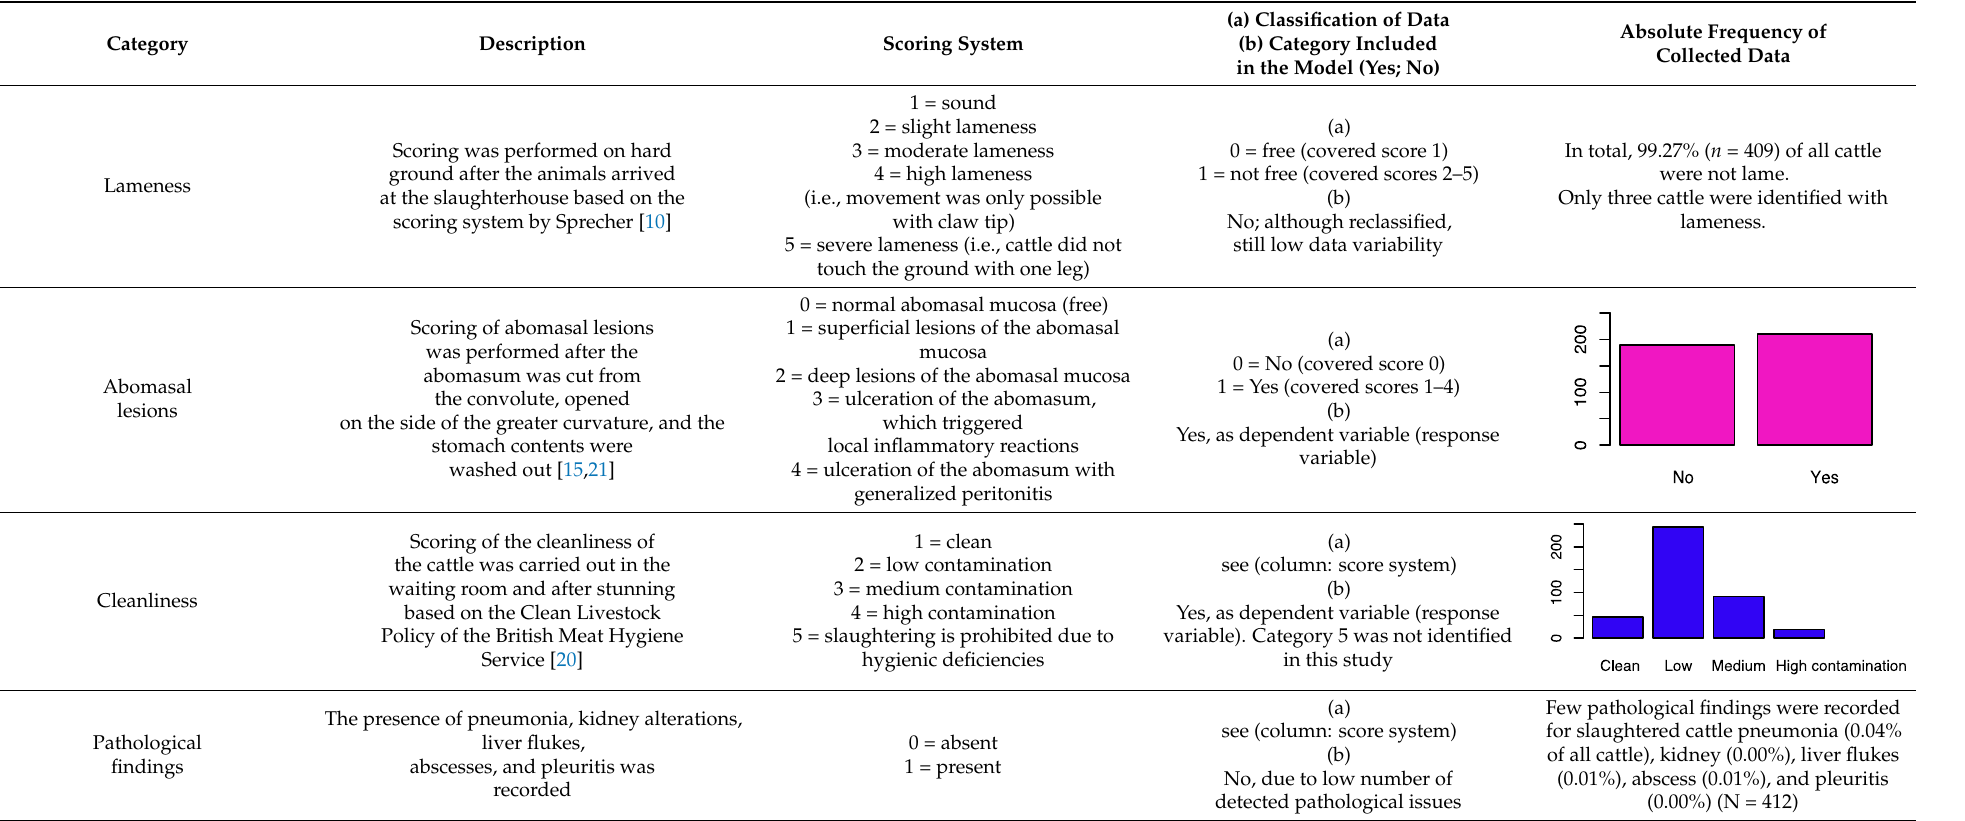
Table 1. Overview of scores, classifications, and distribution of the collected animal welfare and animal-related metadata of slaughter